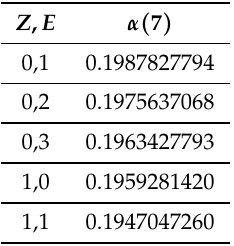
Table 4. Allowed ruin